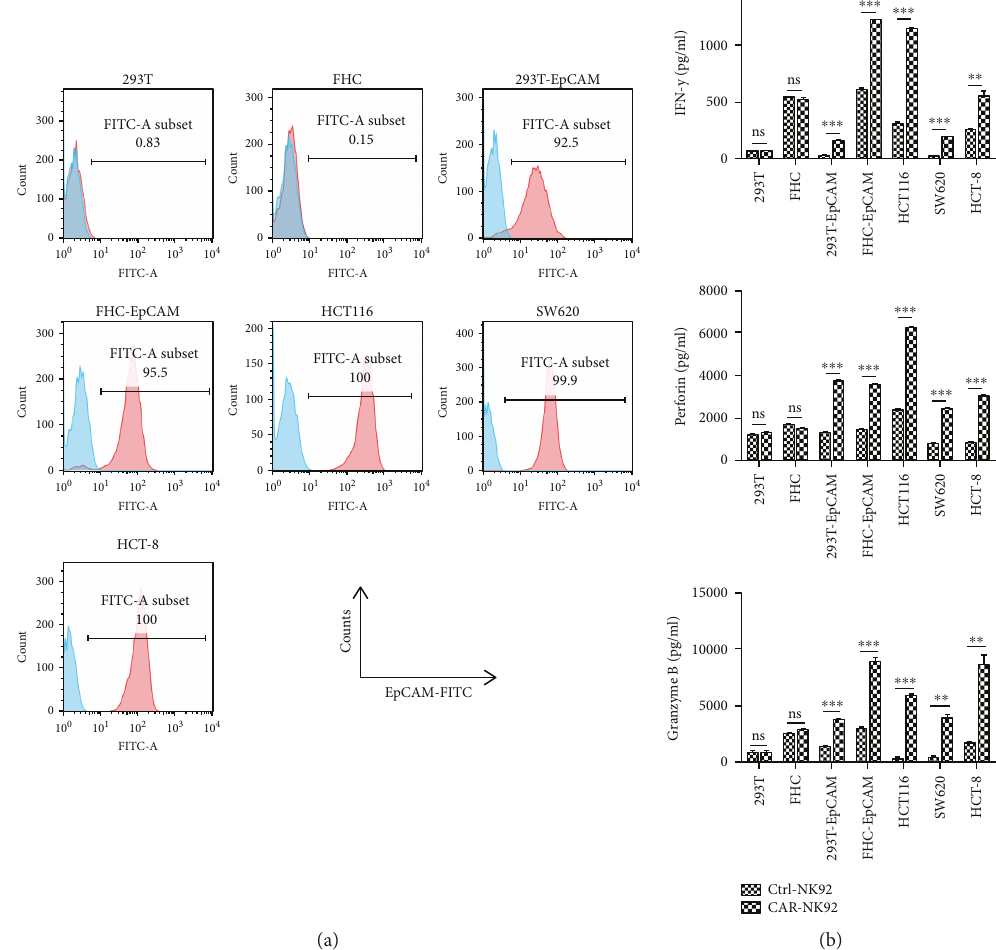
Figure 2: Speci fi c cytokine release of EpCAM-speci fi c CAR-NK-92 cells against EpCAM-positive cells. (a) FACS was used to test the surface expression of EpCAM proteins in 293T, 293T-EpCAM, FHC, and FHC-EpCAM cells and the human colorectal cancer cell lines HCT116, SW620, and HCT-8. (b) The levels of cytokines, released by Ctrl-NK-92 and CAR-NK-92 cells, were measured by enzyme-linked immunosorbent assay (ELISA) after incubation for 24 h with EpCAM-negative or EpCAM-positive target cells at an e ff ector-to-target (E/T) ratio of 2:1. ∗∗ p < 0 01 ; ∗∗∗ p < 0 001 ; ns: not signi fi